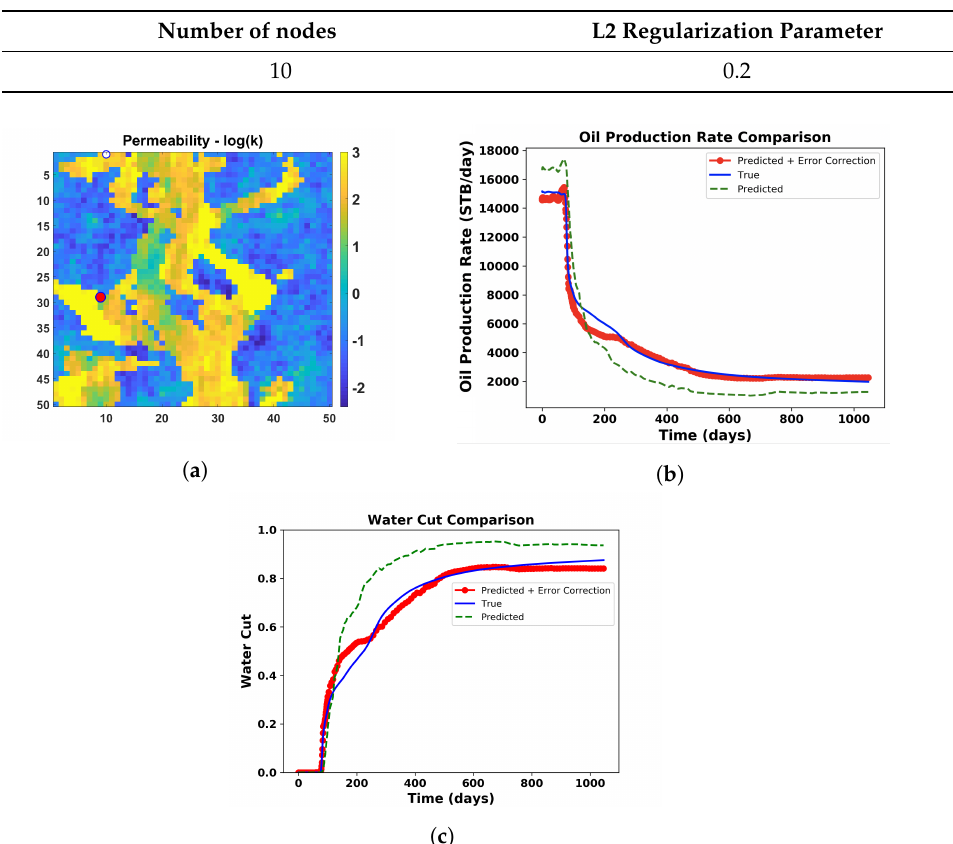
Figure 45. ( a ) Test case 1 with the producer well location at (9,29). ( b ) Comparison of the oil production rate and ( c ) comparison of water cut, predicted using the global PMOR method alone (dotted green line) and after the implementation of error correction model (red circled line) with the true solution (blue